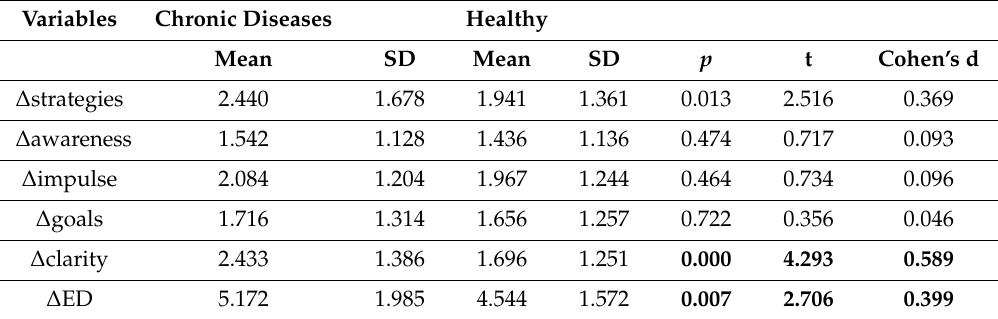
Table 6. Di ff erences between groups: independent samples t -test and Cohen’s d coe ffi cient. Gr. 1: chronic disease, n = 137; Gr. 2: healthy persons, n = 146.